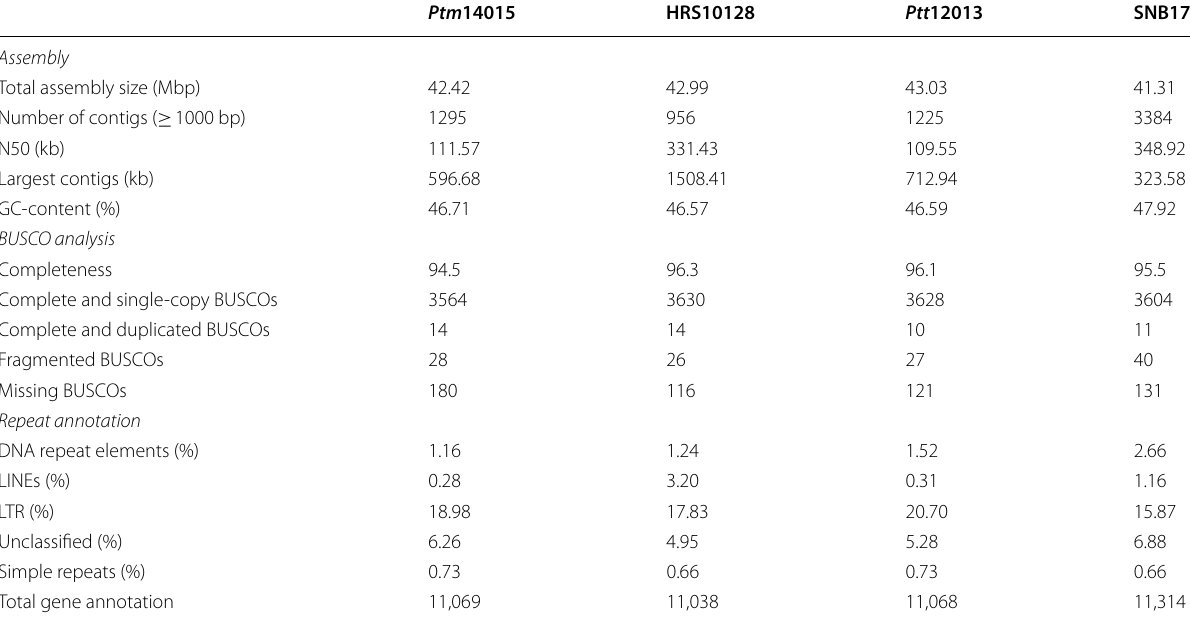
Table 1 Genome assembly statistics of the four Pyrenophora teres isolates from barley